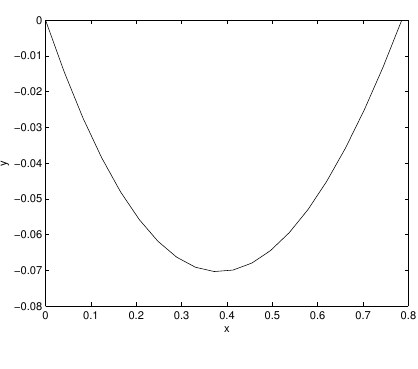
Figure 1. Solution of (3.5) for A = B =